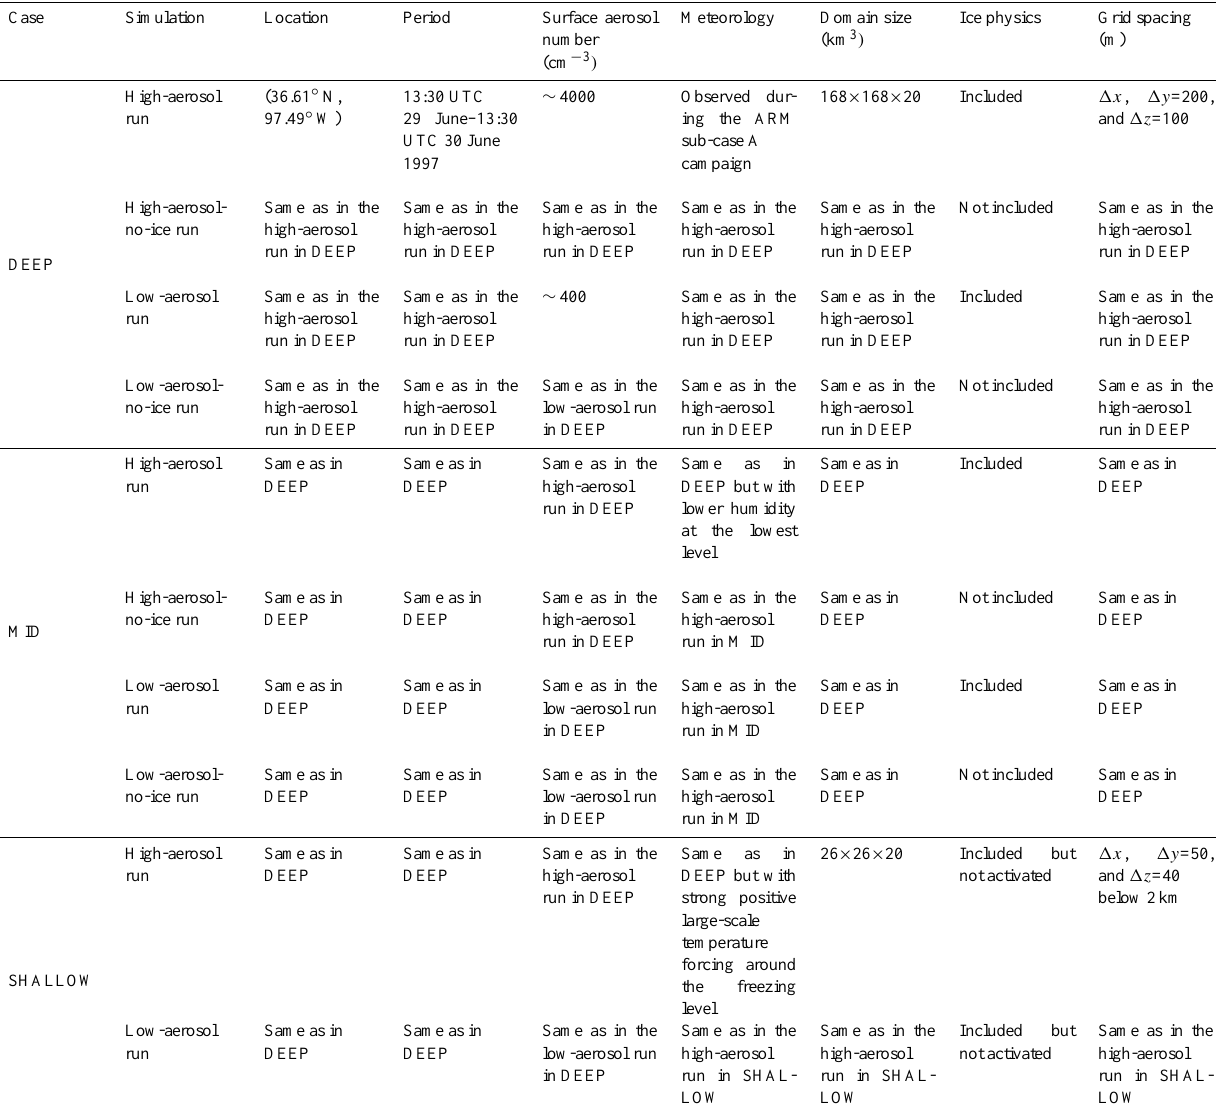
Table 1. Summary of